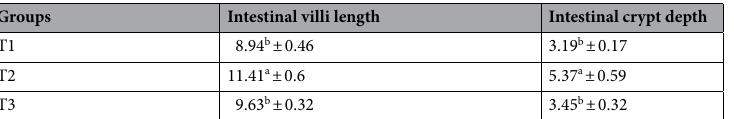
Table 6. Effects of ZnONPs supplementation on intestinal villi length and crypt depth of broiler chicks. Values are means ± SEM. a, b—Means in the same column with different superscripts are Significantly different ( P <0.05).